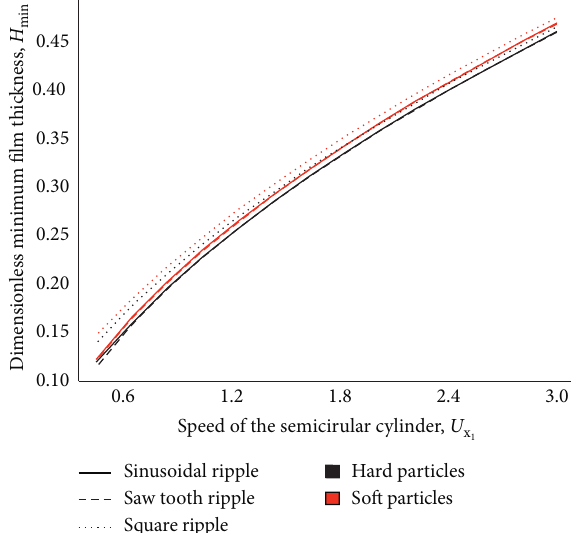
Figure 15: The nondimensional minimum film thickness with different speeds of the semicircular.